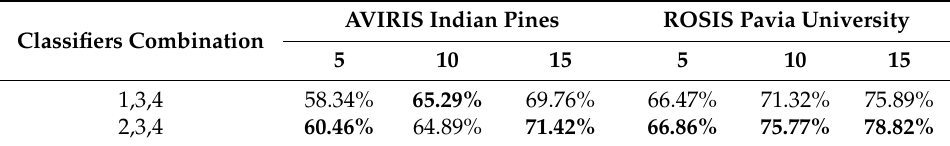
The optimal combination selected by the diversity measures and tri-training (TT) (overall